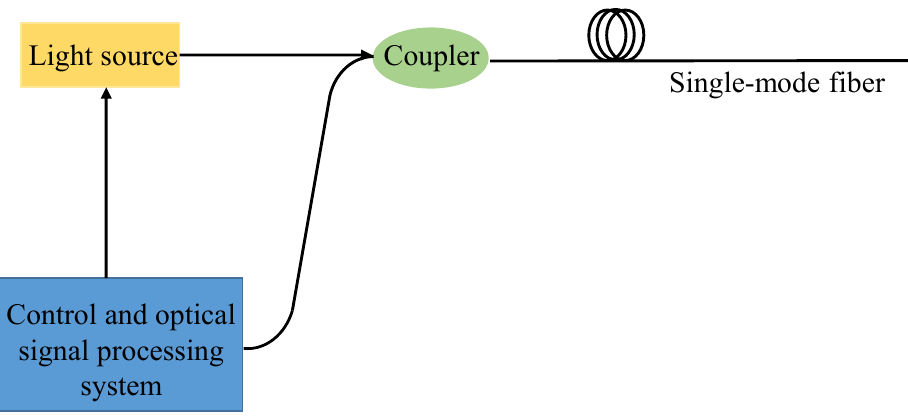
Figure 2. Schematic diagram of the signal acquisition device.